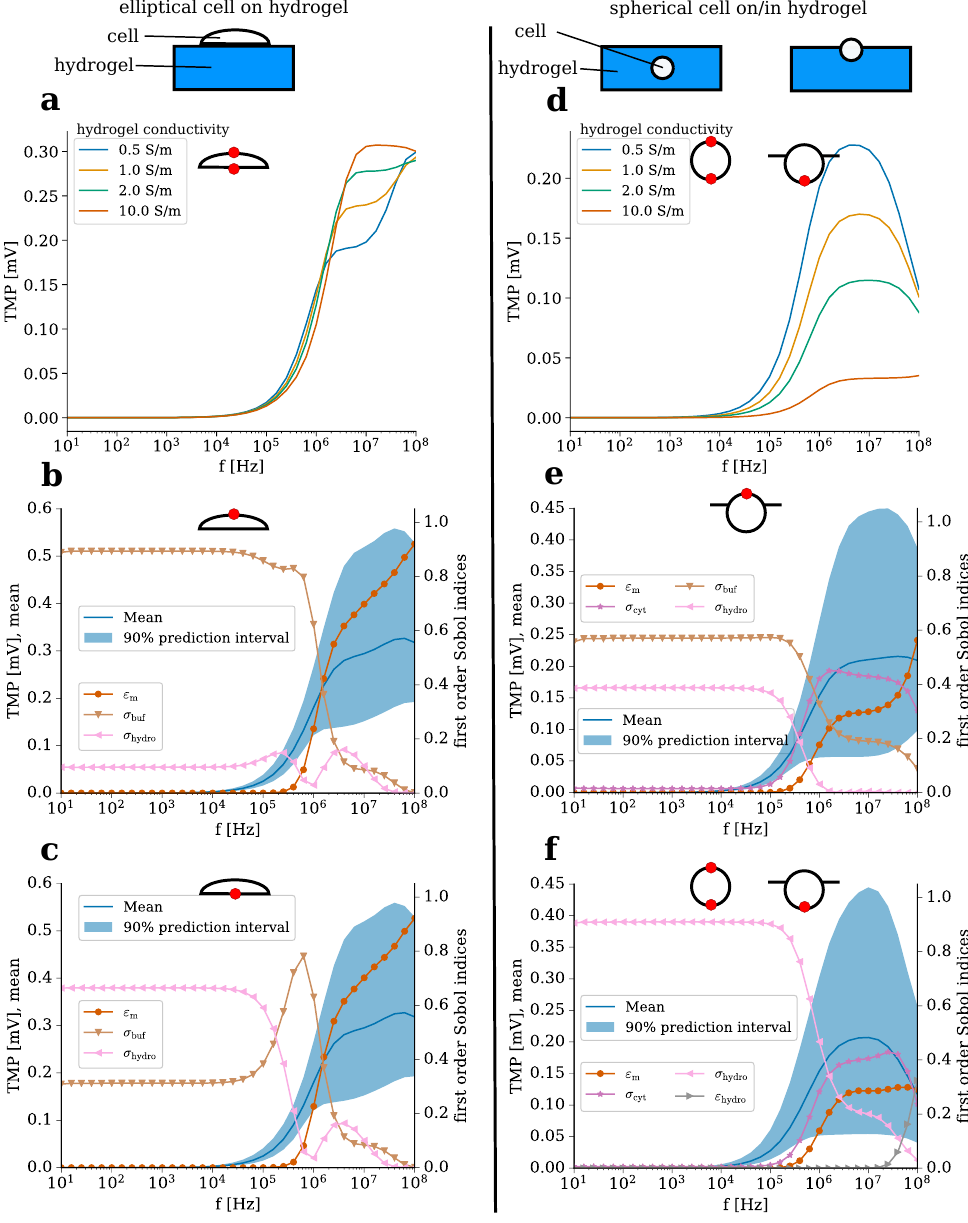
Figure 6. Comparison of an elliptical cell on the top surface of the hydrogel ( a – c ) and a spherical cell seeded on/centred in the hydrogel ( d – f ). Here, we only report the case where the cell is located at the hydrogel–medium interface since there is a difference between the TMP at the top and bottom of the cell to be expected (Figure S8). The result for a single cell centred in the hydrogel is shown in Figure S9. It almost perfectly resembles ( f ). In each part of the figure, the point on the cell membrane, where the TMP was evaluated (or could have been evaluated yielding similar results in case of the spherical cell), is indicated by a red dot. The TMP for different hydrogel conductivities is compared ( a , d ). In ( b – f ), the UQ results are shown. The mean and the 90% prediction interval (left axis) are shown together with the first order Sobol indices of the uncertain parameters (right axis). Tested parameters whose Sobol index does not exceed 0.1 over the entire frequency are not shown for the convenience of the reader. Hence, only results for membrane permittivity ( ε m ), cytoplasm conductivity ( σ cyt ), buffer conductivity ( σ buf ), hydrogel conductivity ( σ hydro ), and permittivity ( ε hydro ) are